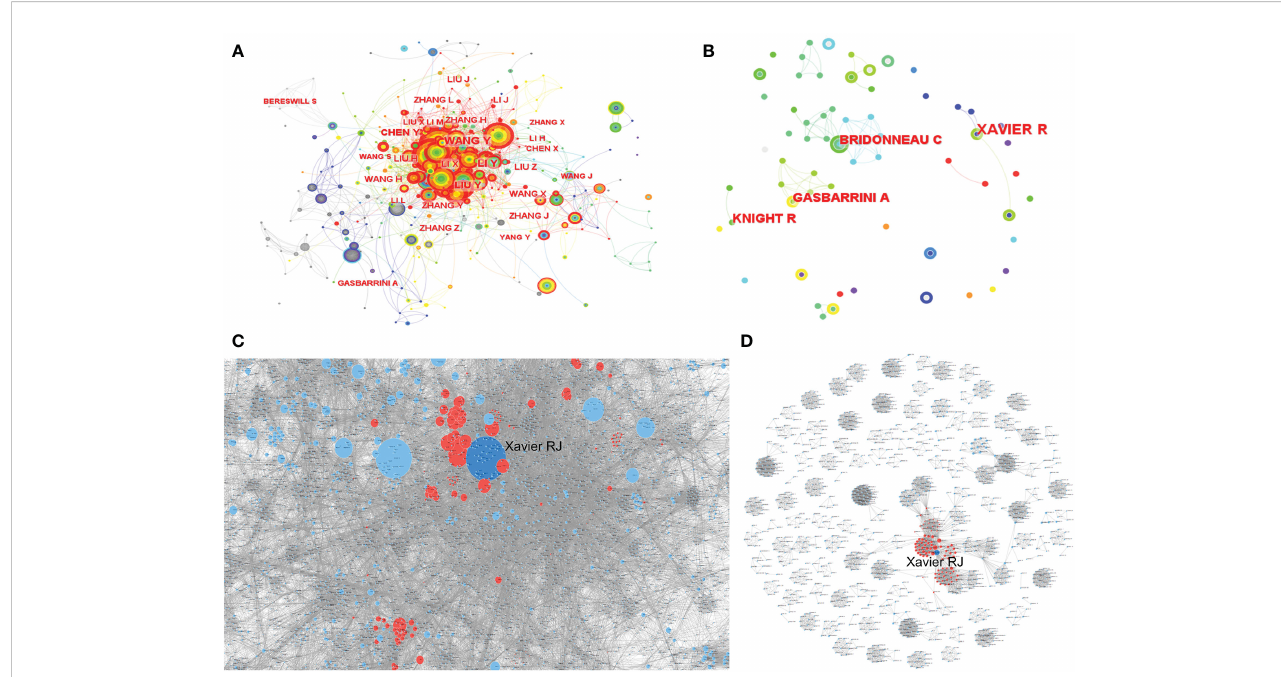
FIGURE 2 The co-occurrence of authors (A, B) and the cooperation relationship between authors (C, D) of relevant literature. ( A, C : all relevant literature; B, D : citation classics; C, D : Each small blue dot represents an author, the link represents collaboration, and the larger the blue dot, the more collaboration. The dark blue dots are the authors who collaborated the most, and the red dots are the authors who collaborated with that